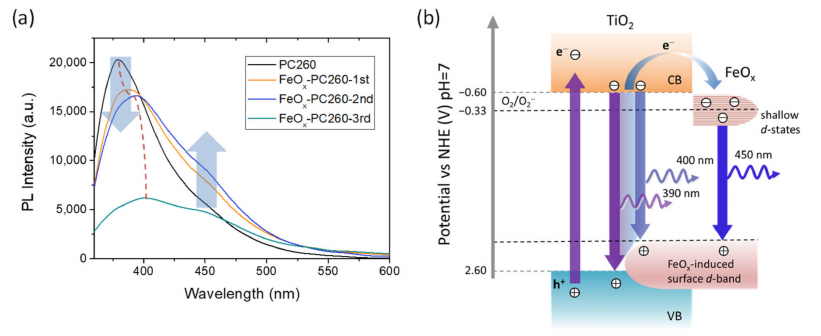
Figure 7. ( a ) PL spectra of the CCC-modified PC260 films and ( b ) schematic depicting the emission processes in FeO x –PC under UV excitation. The anatase band edge positions were taken from